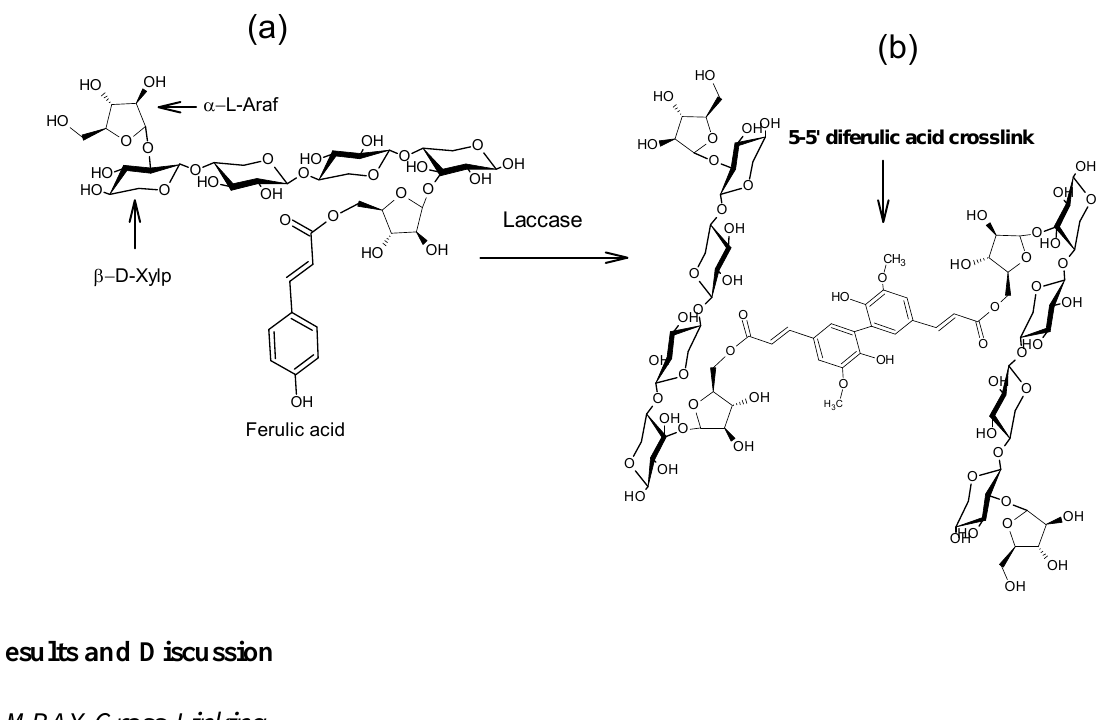
Figure 1. Schematic representation of the covalent cross-linking of ferulated arabinoxylans. Ferulated arabinoxylans ( a ) in solution and ( b ) in gel. Covalent cross-linking through a 5,5 diferuloyl moiety in the gel is presented as an example. α - L -Araf = α - L -arabinofuranose, β - D -Xylp = β - D